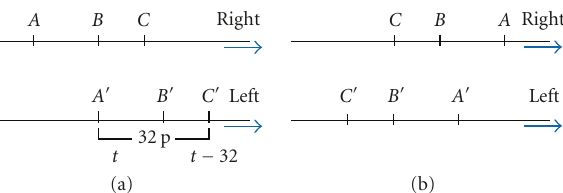
value is put out. If the two values di ff er, we transmit the last left-referenced disparity value in order to correct occlusion boundaries or bad matches. Significant corrections at occlusion boundaries are found using this